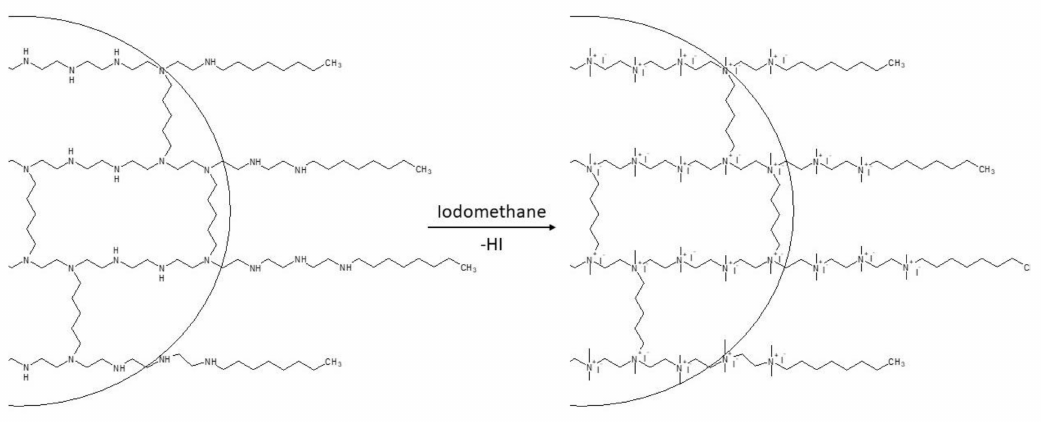
Figure 5. The quaternization step that occurs in both methods. Adapted from